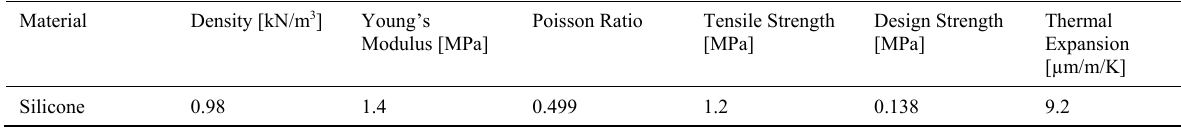
Table 1: Structural Silicone Material